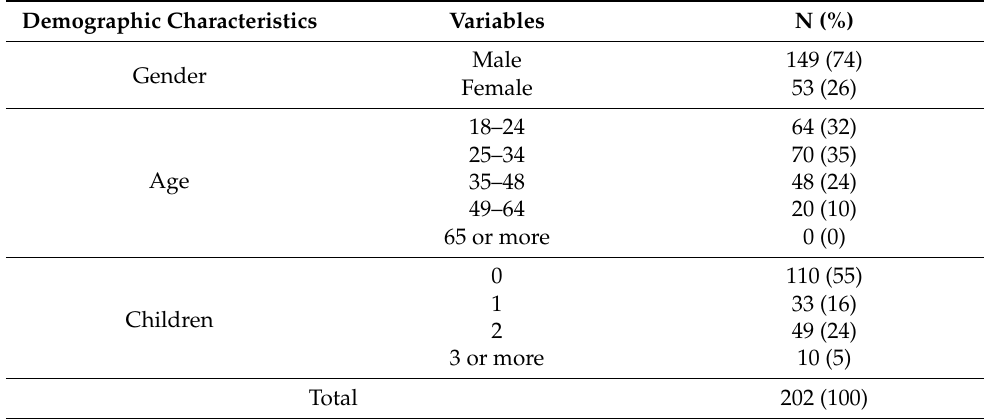
Table 1. Demographic characteristics of the respondents.